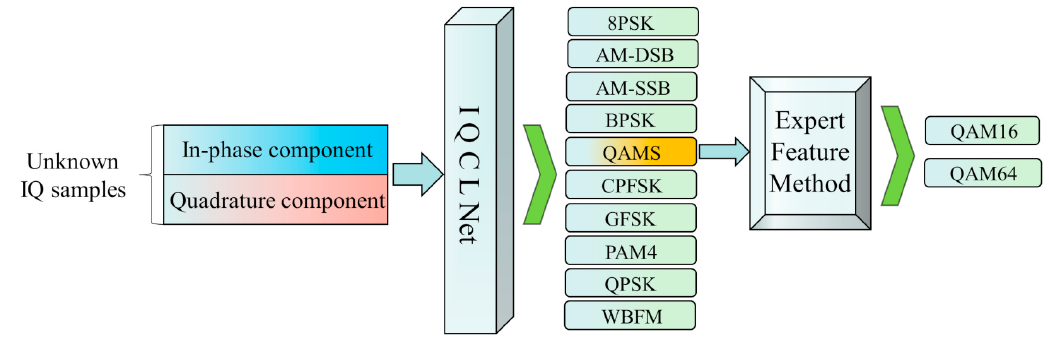
Figure 2. The Joint AMC